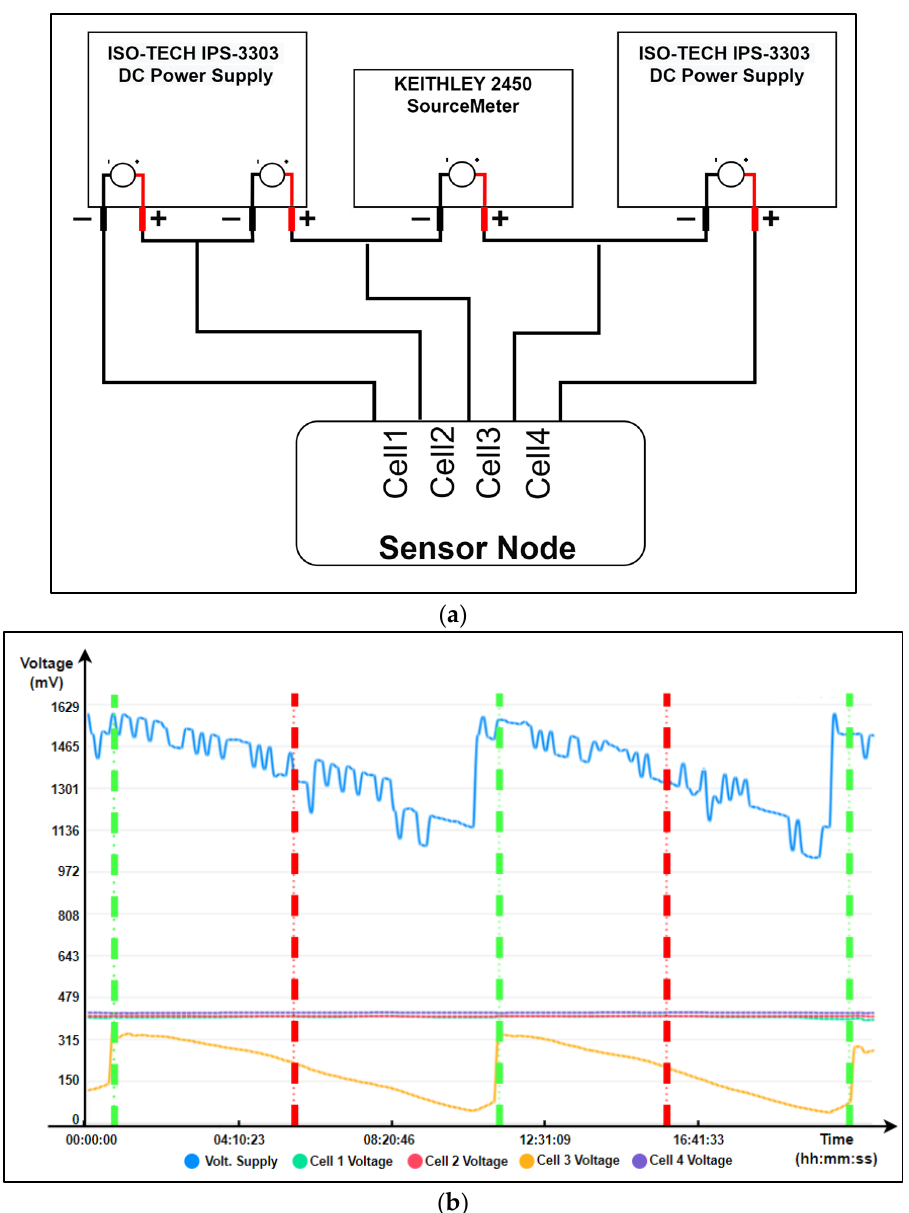
Figure 7. Laboratory test ( a ) Setup. ( b ) Results.